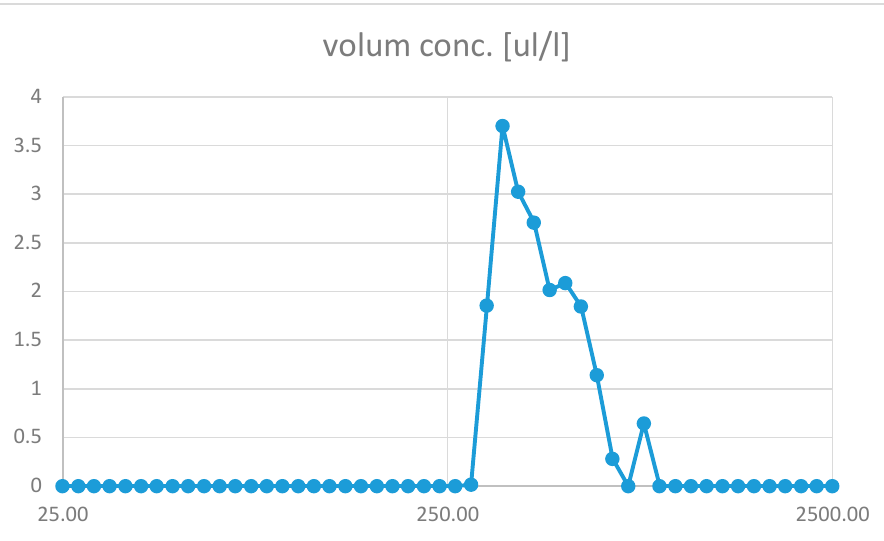
Figure 9. MP size distribution measured in Split.